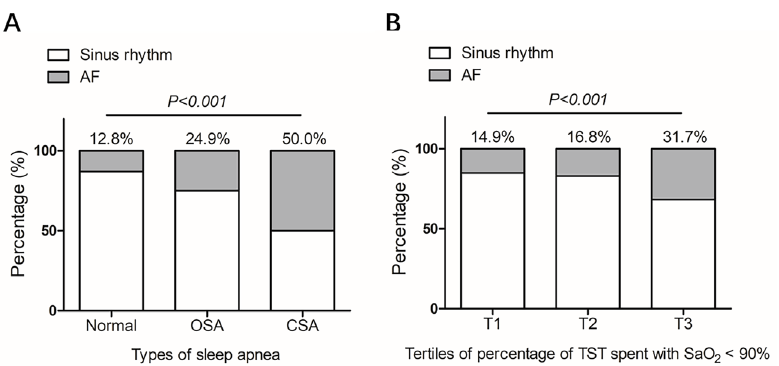
Figure 1. The study flowchart. HCM: hypertrophic cardiomyopathy; OSA: obstructive sleep apnea; CSA: central sleep apnea.